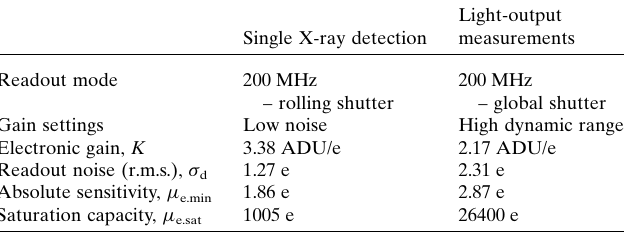
Table 1 Camera settings and measured